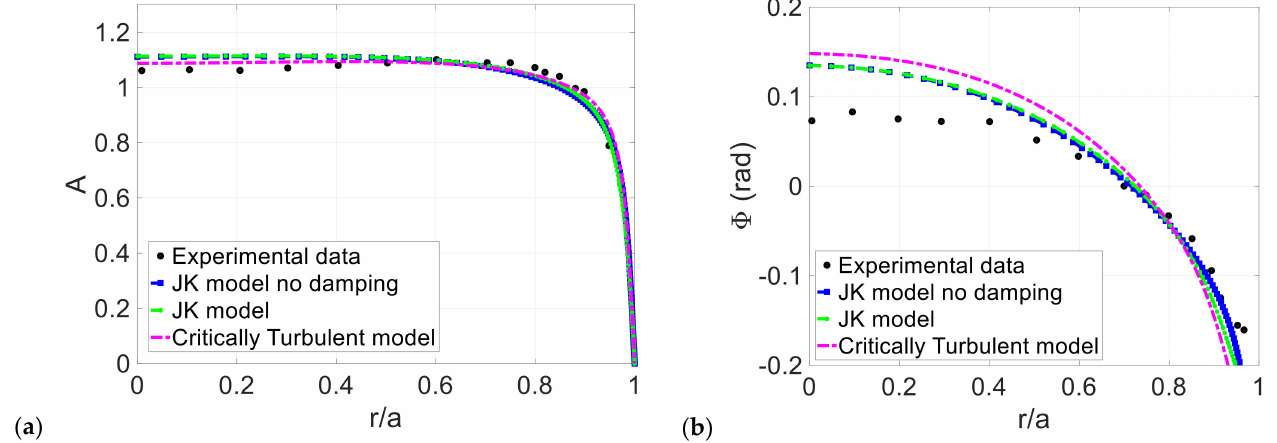
Figure 9. Comparison between experimental data, turbulence models, and the critically turbulent assumption for Case 3: Re os = 20,000, α = 23.4: ( a ) amplitude ratio; ( b ) phase-shift.